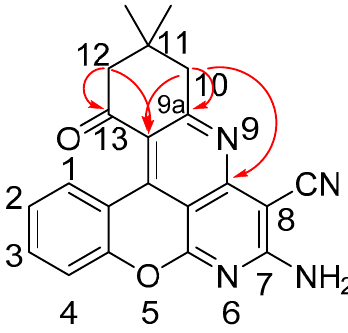
Figure 1. The structure of compound 2a . Key 1 H- 13 C-HMBC spectrum correlations established by NMR are shown by arrows.